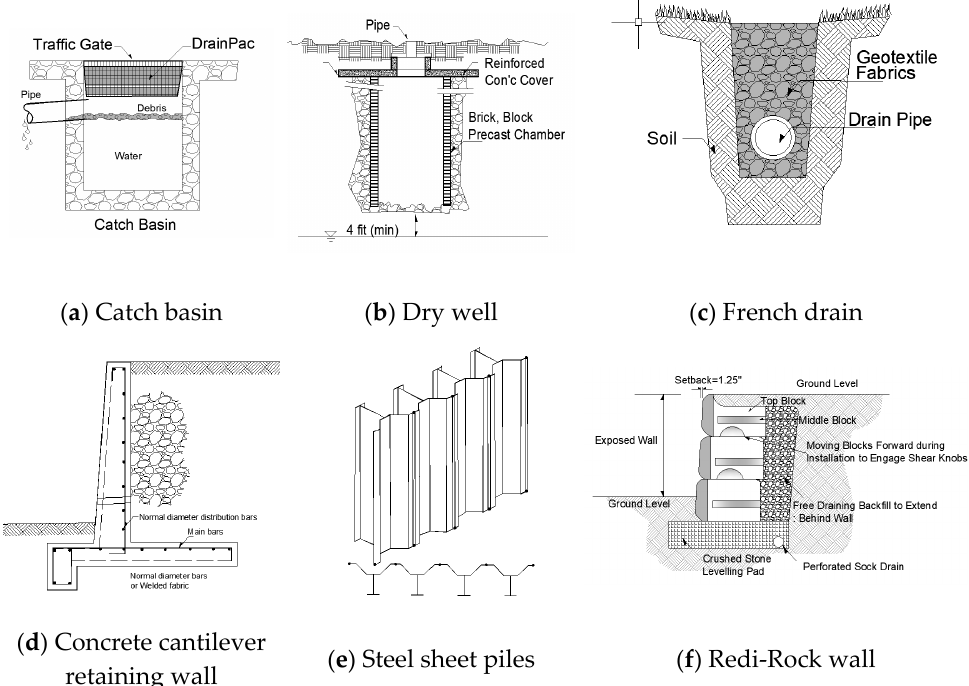
Figure 4. Proposed solutions for drainage management and retaining wall